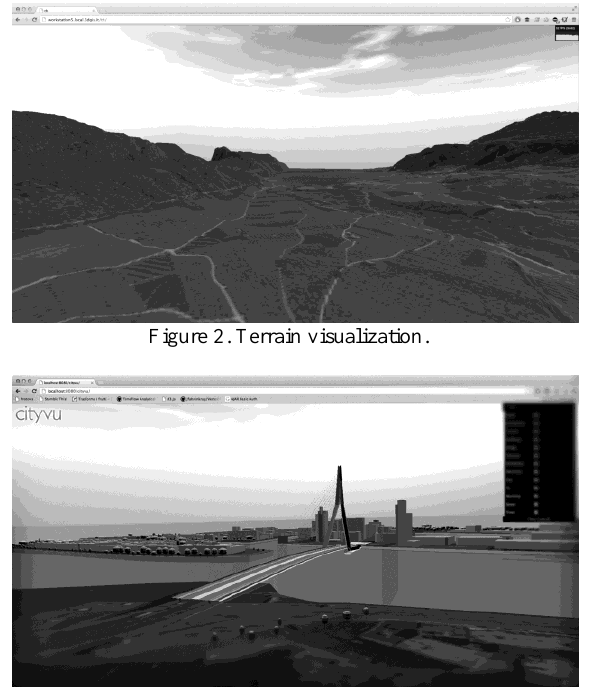
Figure 3. External models and vegetation support.